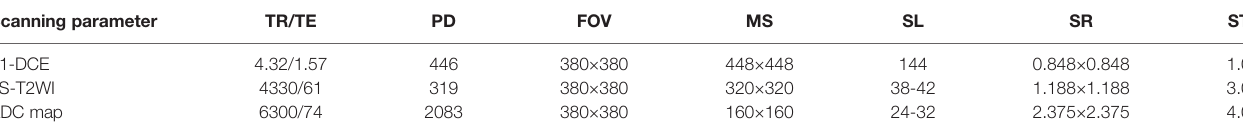
TR/TE, repeat time/echo time (ms); PD, Pixel bandwidth; FOV, fi eld of view (mm); MS, Matrix size; SL, Slicer layer; SR, Spatial resolution (mm 2 ); ST, Slice thickness (mm); T1-DCE, T1- weighted dynamic contrast-enhancement imaging; FS-T2WI, Fat suppression T2-weighted imaging; ADC map, apparent diffusion coef fi cient